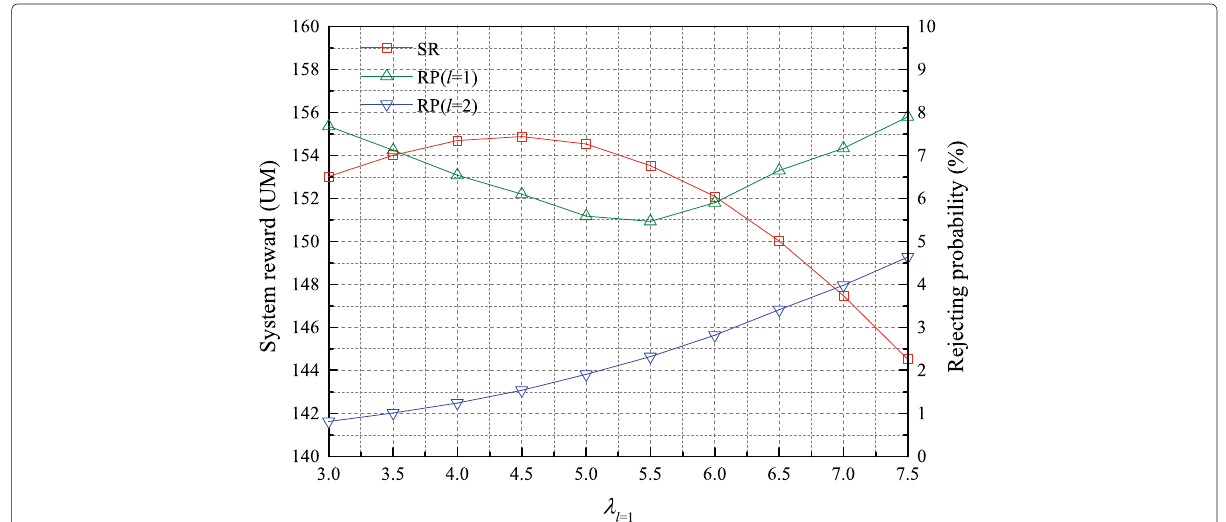
Fig. 7 SR and RPs under different arrival rates of the 1-level task request. This figure shows the evaluation results under different arrival rates of the 1-level task